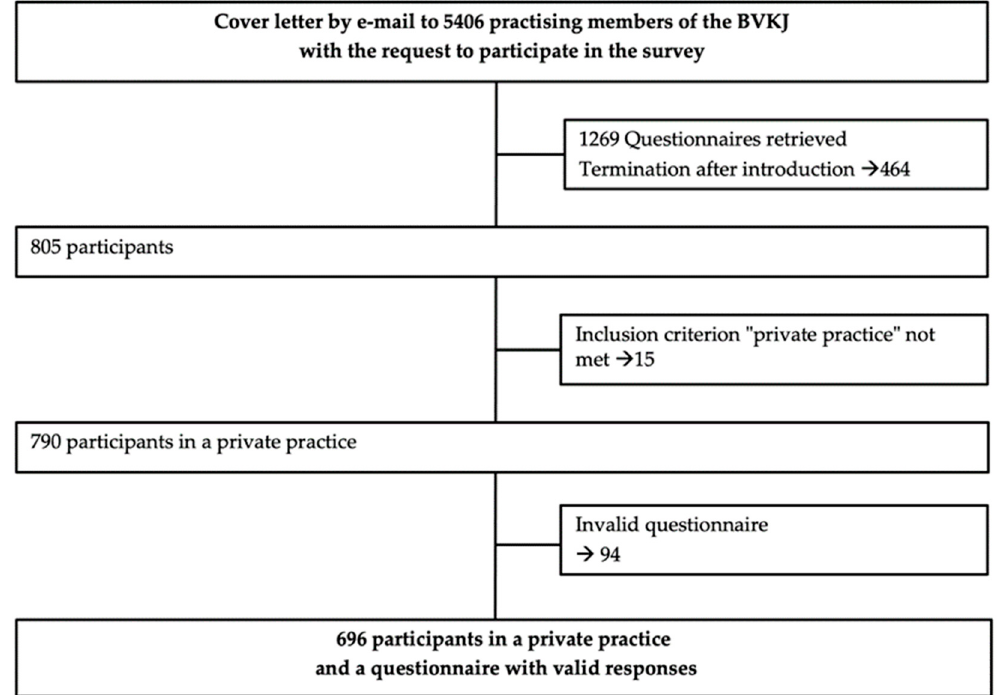
Figure 1. Recruitment scheme of the participating padiatricians in private practice. Table 2. Demographic data of the participants.